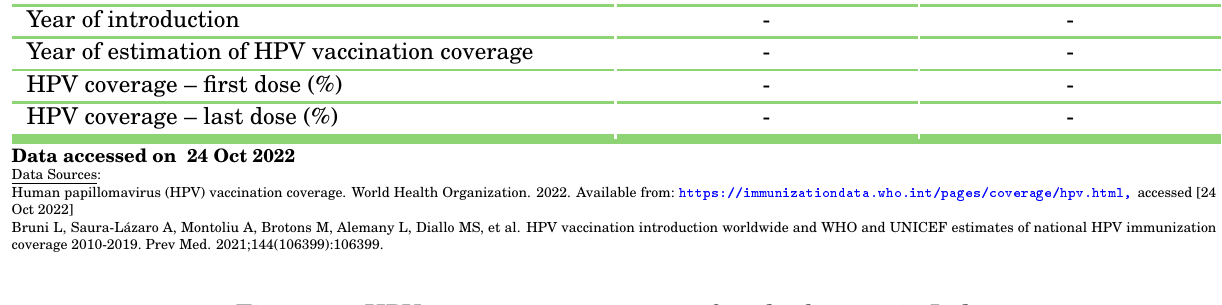
Figure 71: HPV vaccination coverage in females by year in